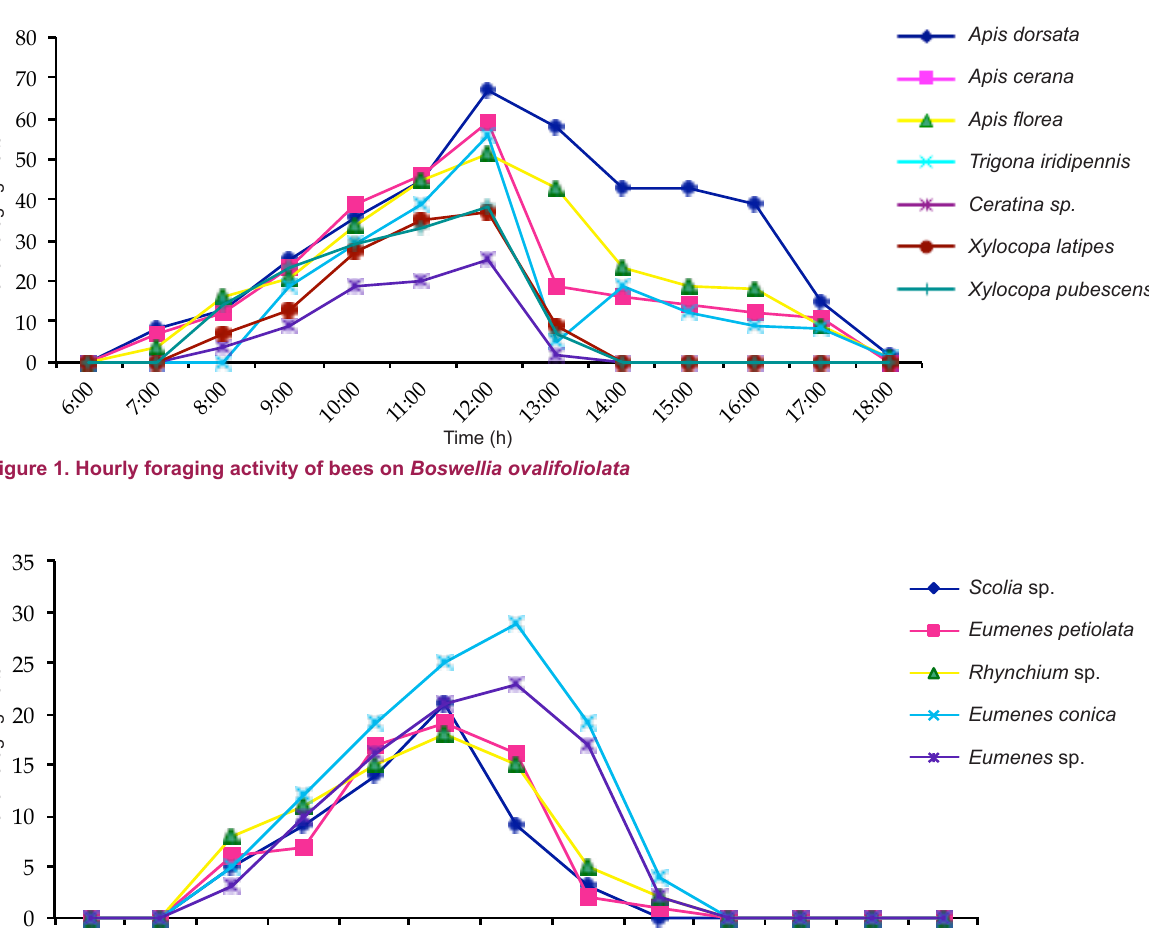
Figure 2. Hourly foraging activity of wasps on Boswellia ovalifoliolata